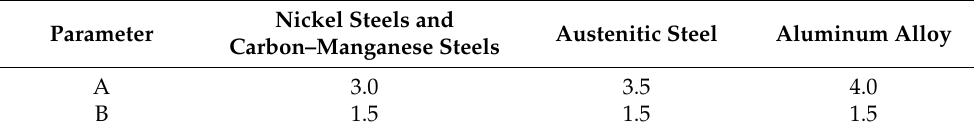
Table 6. A and B for calculation of reference allowable